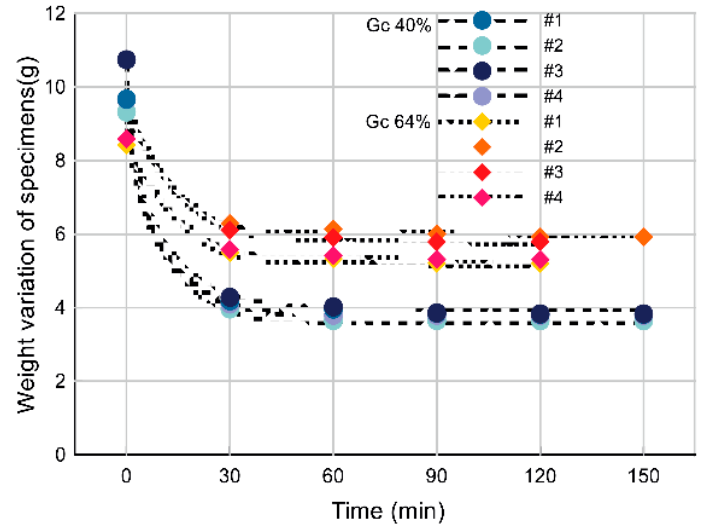
Figure 13. Changes in laminate weight during combustion.